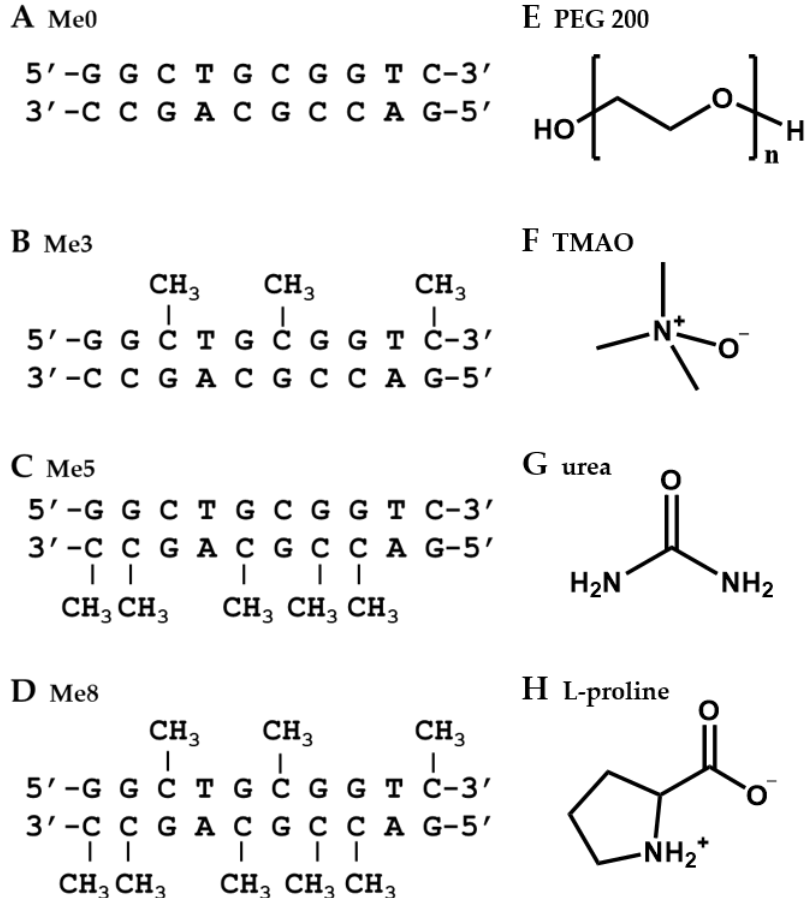
Figure 1. Sequences of DNA oligonucleotides and chemical structure of cosolutes used in this study. ( A ) Me0. ( B ) Me3. ( C ) Me5. ( D ) Me8. Chemical structures of ( E ) PEG200, ( F ) TMAO, ( G ) urea, ( H )